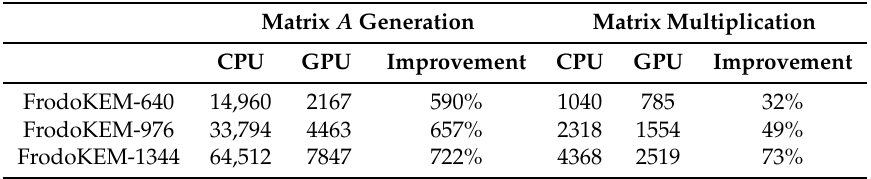
Table 11. Operation time ( µ s) and performance improvements by optimized matrix A generation and matrix multiplication in FrodoKEM (RTX